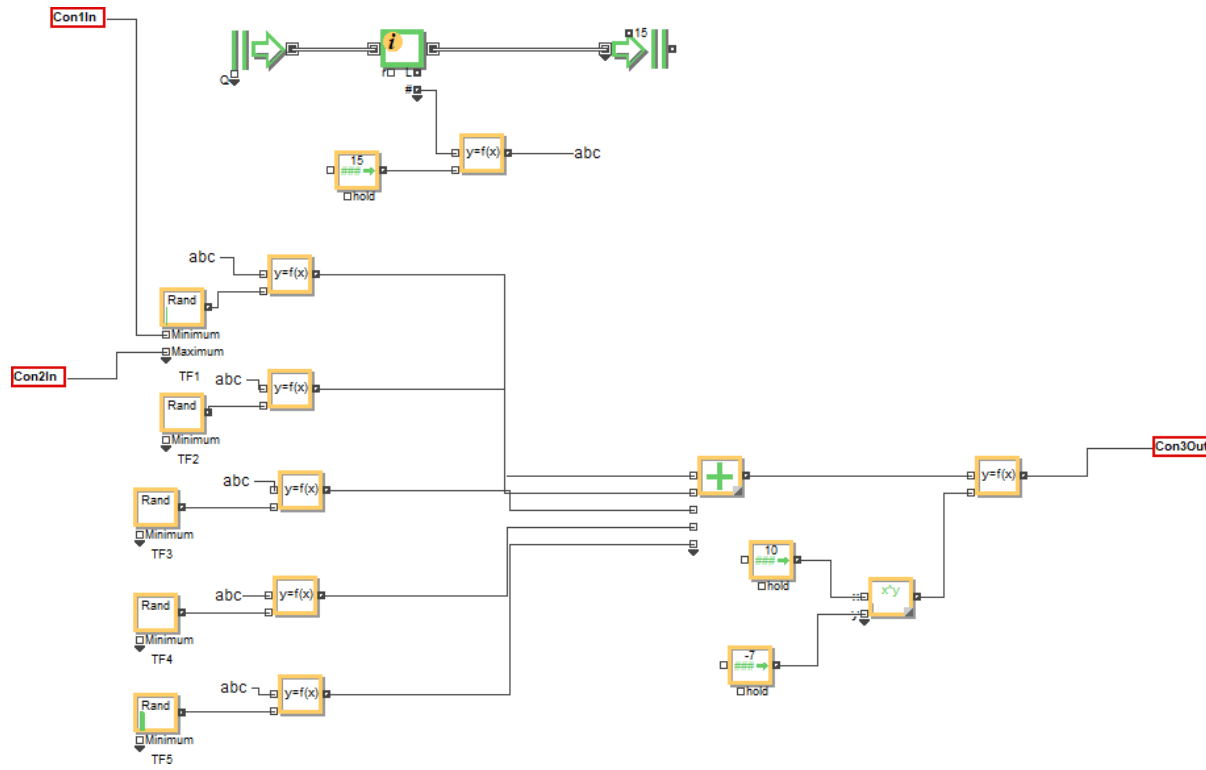
Figure 2: Scheme of simulation with the block “Slider”